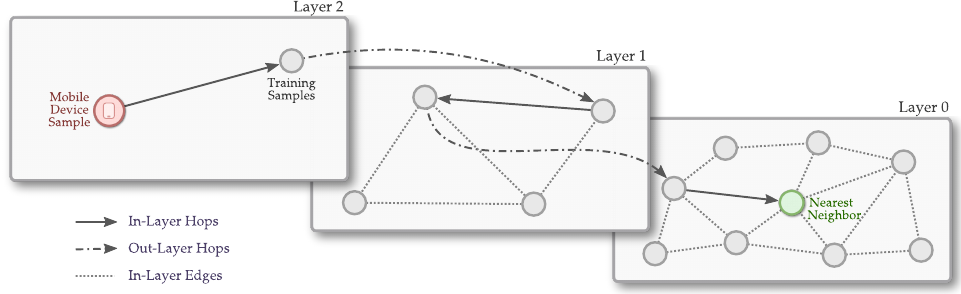
Figure 3. Indoor positioning system classification using hierarchical navigable small world